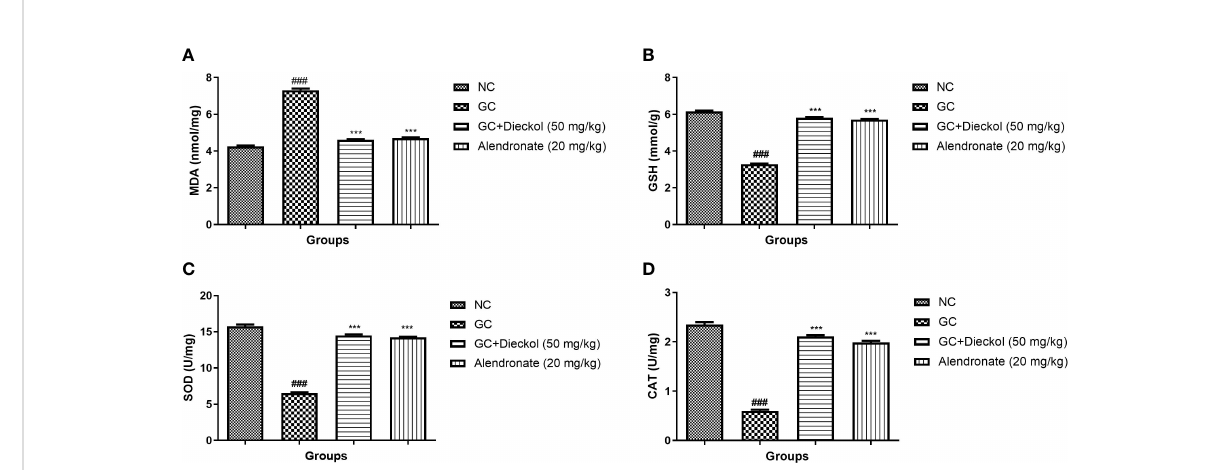
FIGURE 7 Dieckol inhibited glucocorticoid-induced osteoporosis in rats by increasing antioxidant parameters. (A) MDA, (B) GSH, (C) SOD, and (D) CAT. Results are shown as means ± SEM (n = 12). ***P < 0.001 when contrasted with the disease group and the normal